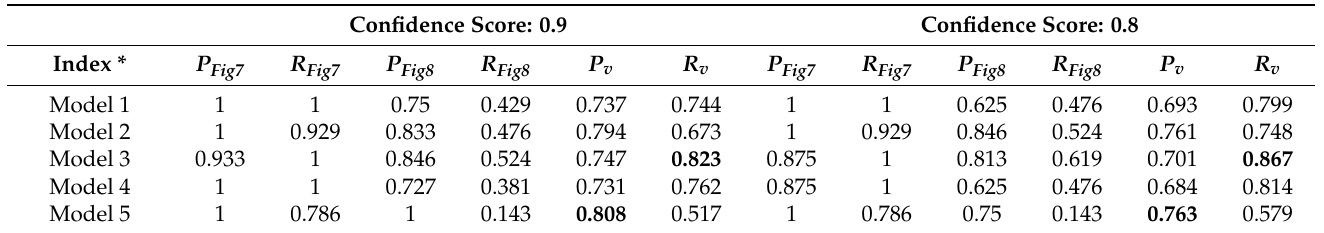
Figure 8. An image with overlapping red blood cells. Table 6. Comparison of the experiment results between Figure 7, Figure 8, and the validation set. Confidence Score: 0.9 Confidence Score: 0.8 Index *